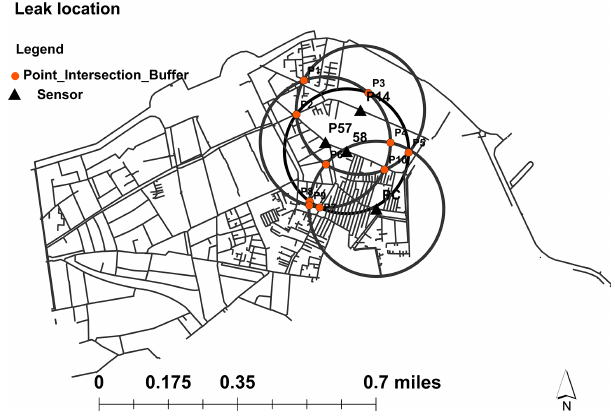
Figure 16. The spatial intersection of circles. Please note that 1mi = 1.609344km.